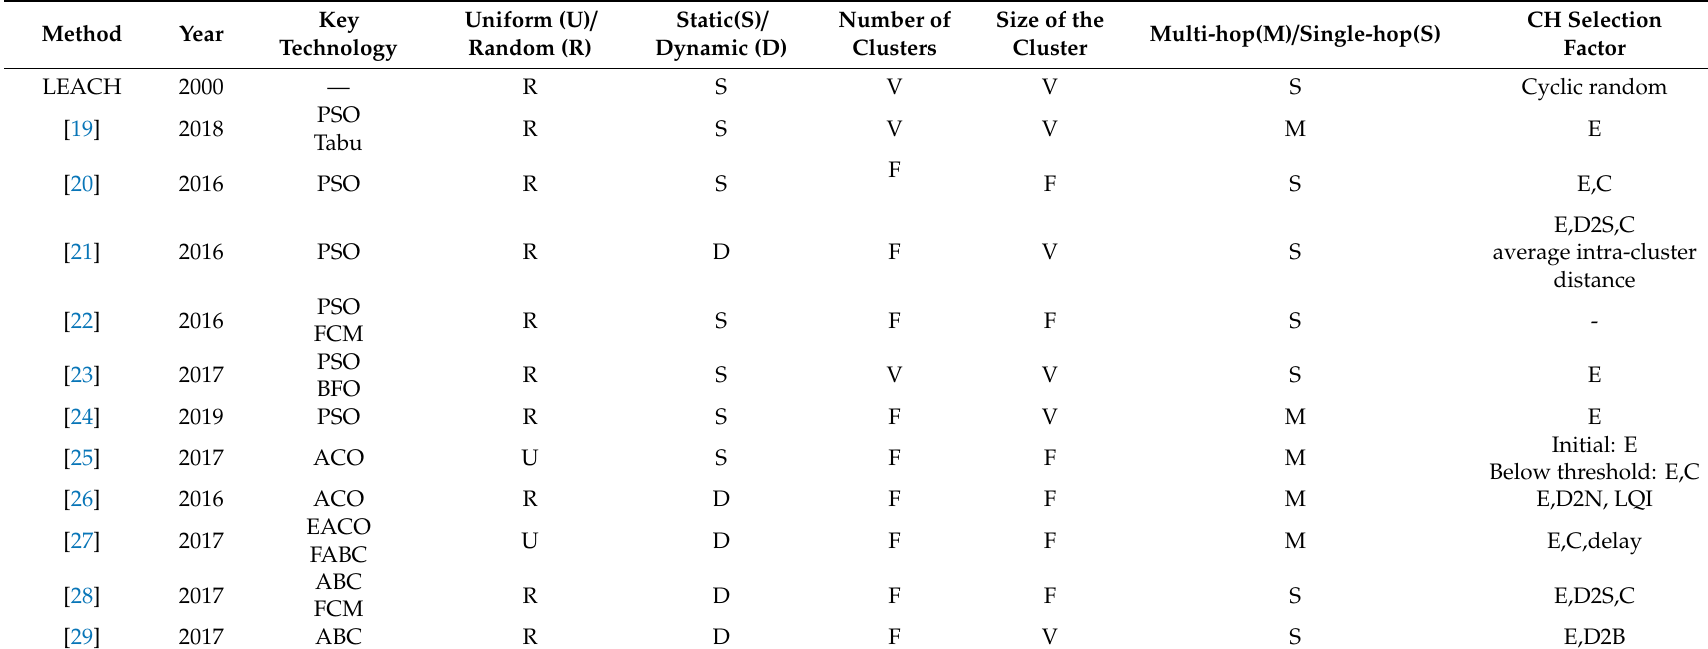
Table 3. CH selection algorithms based on